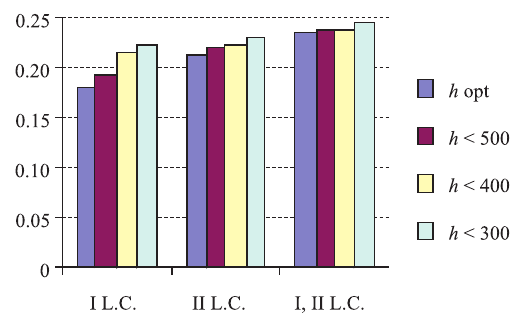
Fig. 10. Comparison of steel expenditures in m 3 for different load cases